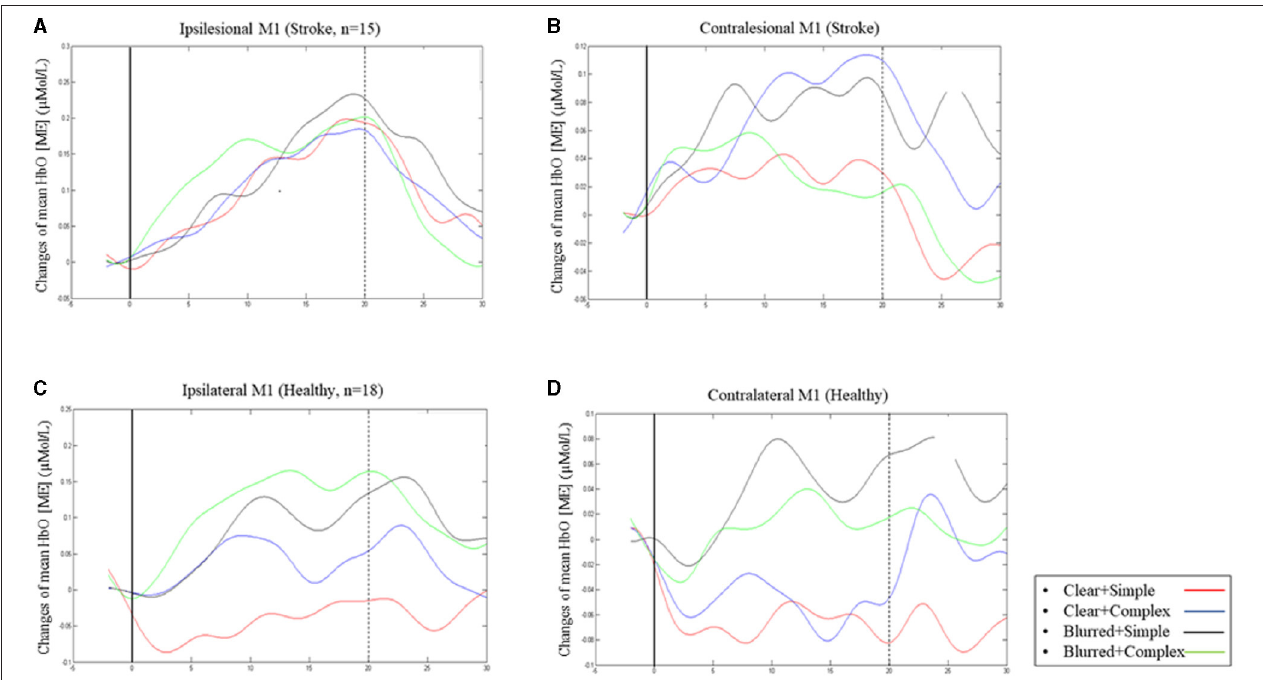
FIGURE 3 | Changes of mean [HbO] (ME) across 20s finger tapping in ipsilesional M1 (A) and contralesional M1 (B) in patient group; changes in mean [HbO] (ME) in ipsilateral M1 (C) and contralateral M1 (D) in healthy group.